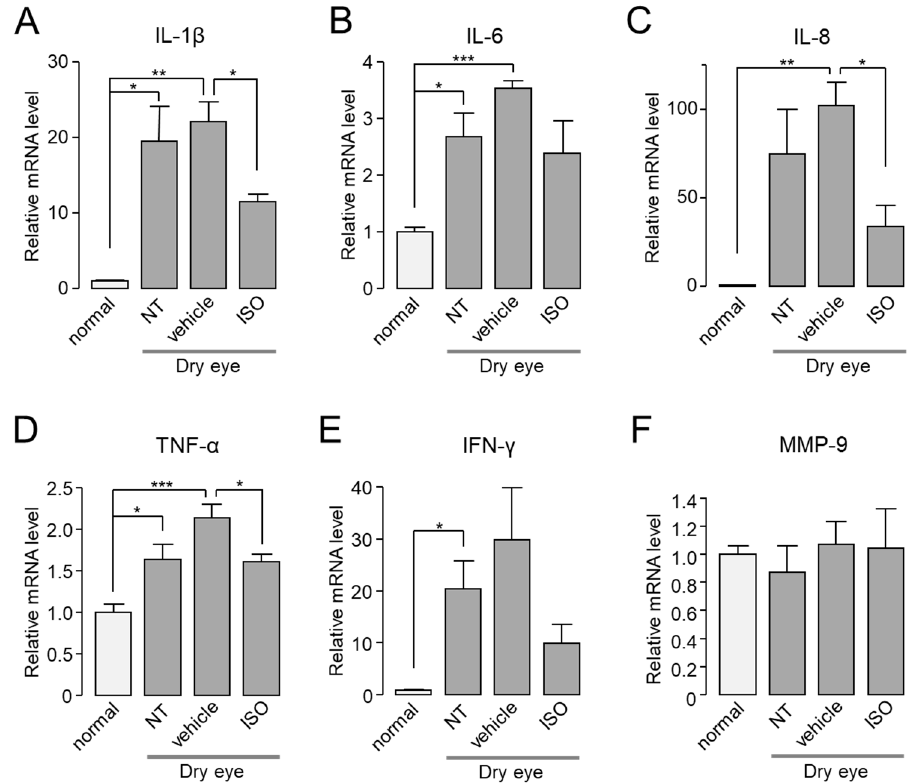
Figure 7. In dry eye mice, isorhamnetin reduced expression of pro-inflammatory cytokines in cornea and conjunctiva. ( A – F ) The mRNA expression level of IL-1 β , IL-6, IL-8, TNF- α , IFN- γ , and MMP-9 in cornea and conjunctiva. Mice treated with dry eye model for 14 days, and dry eye mice treated with vehicle or isorhamnetin for 10 days while maintaining the dry eye condition (mean ± S.E., n = 4–5). NT, not treated. * p < 0.05, ** p < 0.01, *** p < 0.001.